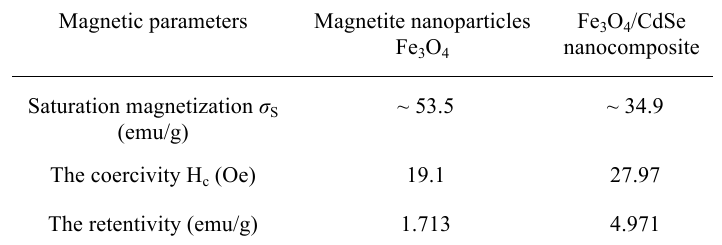
Table 1. The magnetic parameters of Fe